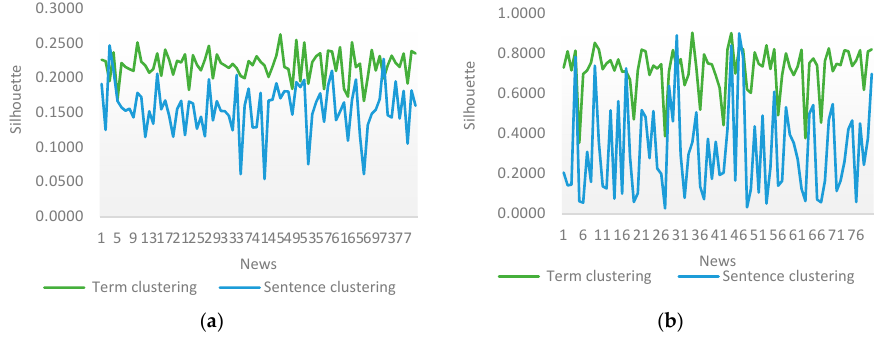
Figure 2. Results of the Silhouette measure for the two clustering approaches in the topic detection on the TelecomServ dataset by applying ( a ) WordNet and ( b ) word embeddings based semantic processing approaches.